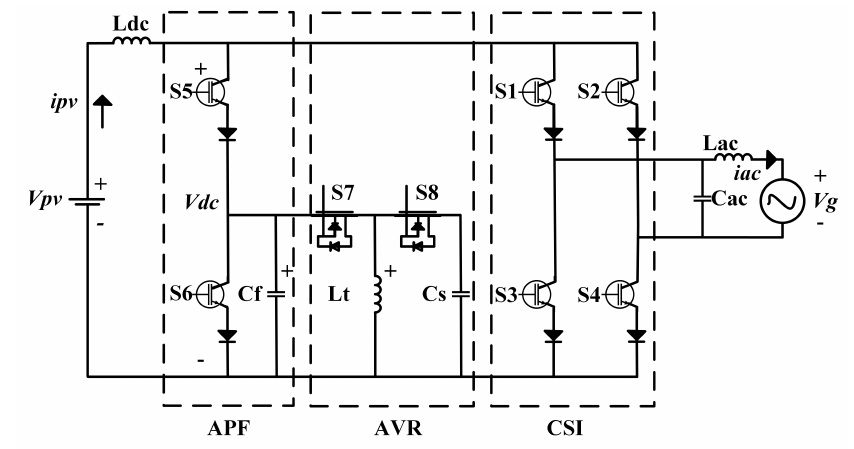
Figure 16. Power decoupling circuit for CSI.